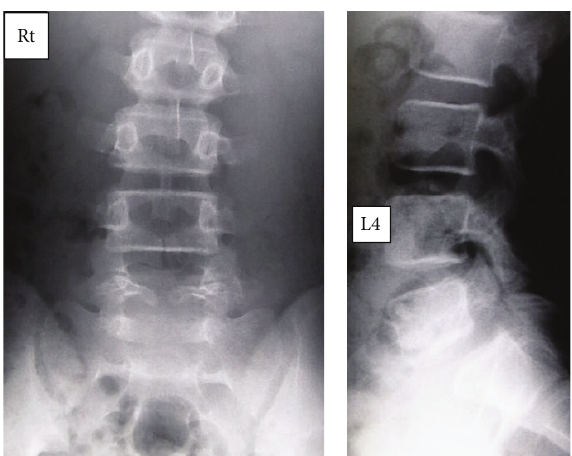
Figure 1: Plain radiographs of Case 1. Spina bifida occulta (SBO) and L5 isthmic olisthesis are obvious.